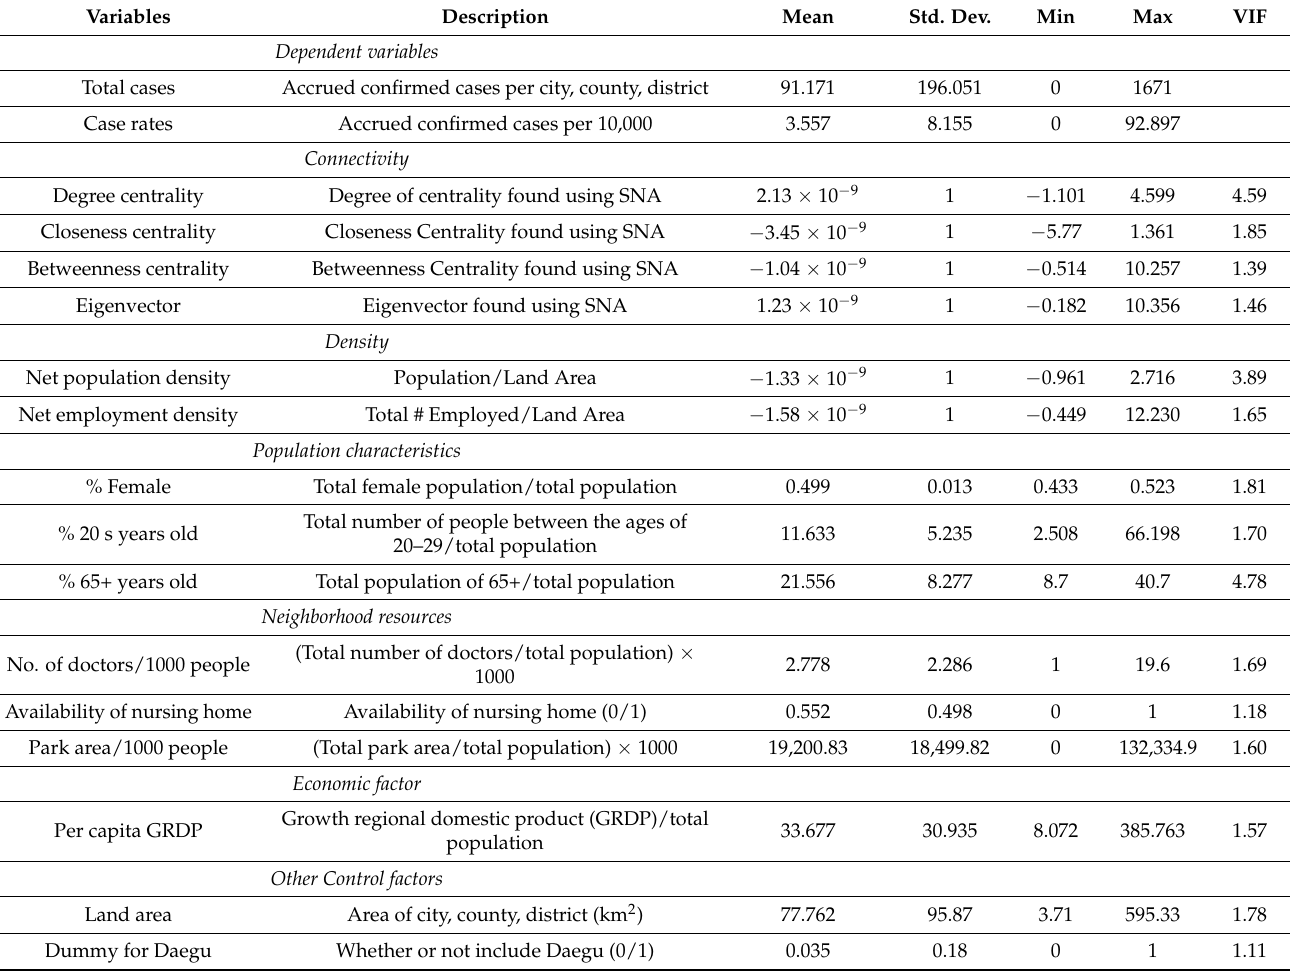
Table 2. Descriptive summary of the study variables ( n =